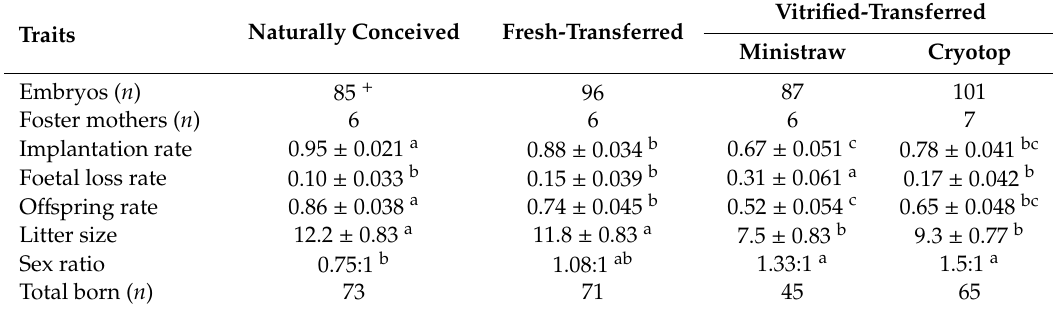
Table 1. Implantation rate, foetal loss rate, o ff spring rate, and sex ratio in o ff spring born after natural conception, fresh embryo transfer, vitrified embryo transfer using ministraw, and vitrified embryo transfer using